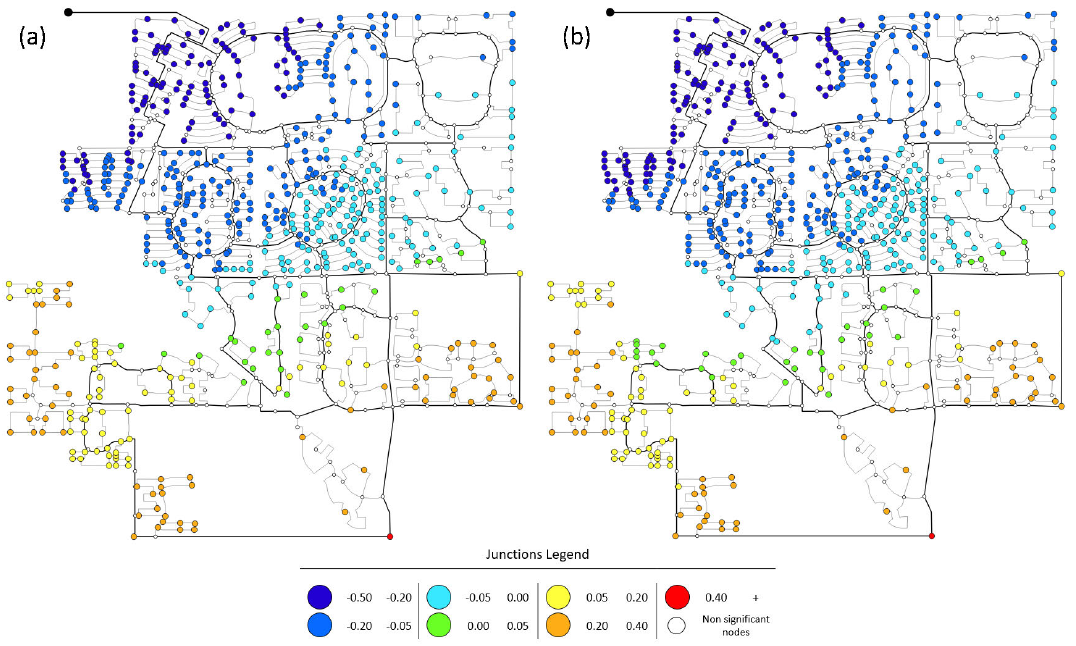
Figure 7. Graphs containing the local pressure head surplus index, for a peak coefficient P c = 2.25. ( a ) DDA simulation result. ( b ) PDA simulation